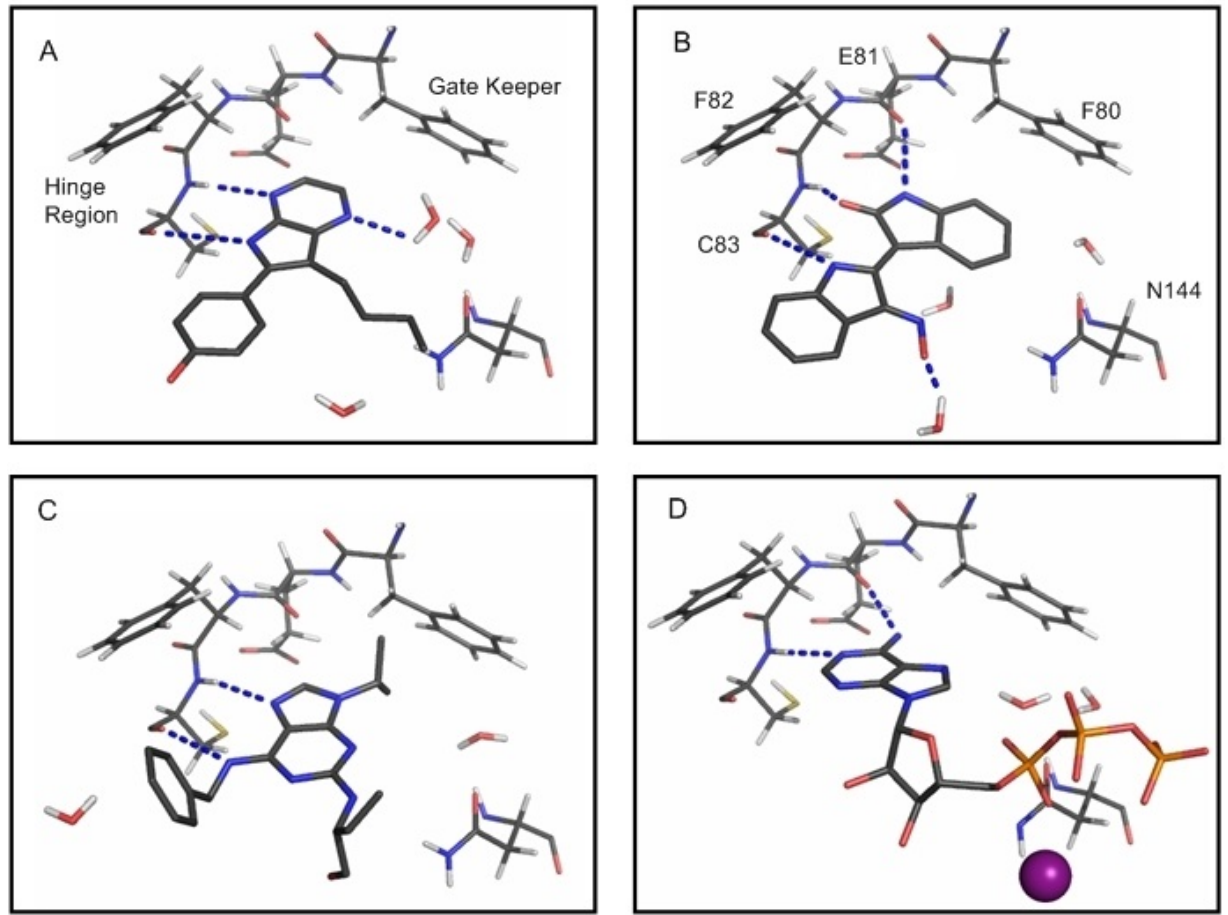
Figure 12. Depiction of the main interactions formed between the ligand (sticks), waters (sticks) and residues (lines) in the ATP-binding site of the CDK5 D144N /p25 mutant. ( a ) Aloisine-A; ( b ) indirubin-3'-oxime; ( c ) R -roscovitine; ( d ) ATP and Mg 2+ . The dashed lines (blue) indicate H-bonding between the ligand and the surrounding protein and water molecules. The gate-keeper residue, F80, is shown in ( a ) and the residues which make up the hinge region in